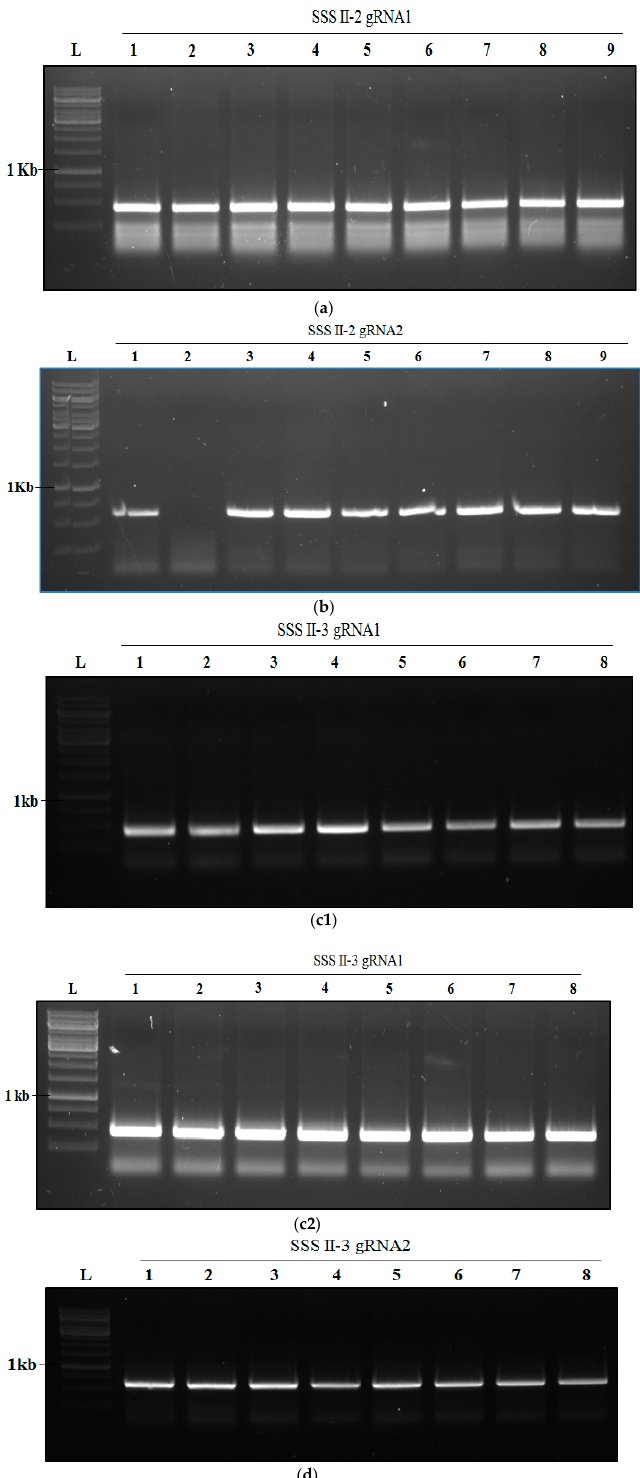
Figure 9. The confirmation of Cas9-free mutant plant lines in the laboratory using PCR. L band is 1 kb DNA ladder. ( a ) Free SSSII-2 gRNA1 genes confirmed by PCR with targeted sequence primers, ( b ) the confirmation of Cas9-free SSSII-2 gRNA2 genes confirmed by PCR with targeted sequence primers, ( c ) the confirmation of Cas9-free SSSII-3 gRNA1 genes confirmed by PCR with targeted sequence primers, and ( d ) the confirmation of Cas9-free SSSII-3 gRNA2 genes confirmed by PCR with targeted sequence primers. c1 and c2 , same gene targeted by two rRNAs Table 2. Sequencing analysis for Cas9-free plant lines mutated (knocked out—KO) at SSII-1, SSII-2, and SSII-3 genes. The results of sequencing of SSSII-1, SSSII-2, and SSSII-3 mutant lines. The se- quences in yellow are target nucleotide sequences, deletions are shown in dashes, and red nucleo- tides are insertions. Soluble Starch Synthase II-1 Ct-SSS-II-1:ACTTGGGCAGTGCCGAGGAGGAGCAGGTTGGAGTGGGGGC-GTGTGGAGGCTCAGAA-TT KO-SSS-II-1.1:ACTTGGGCAGTGCCGAGGAGGAGCAGGTTGGAGTGGGGGCGGTGTGGAGGCTCAGAATT Soluble Starch Synthase II-2